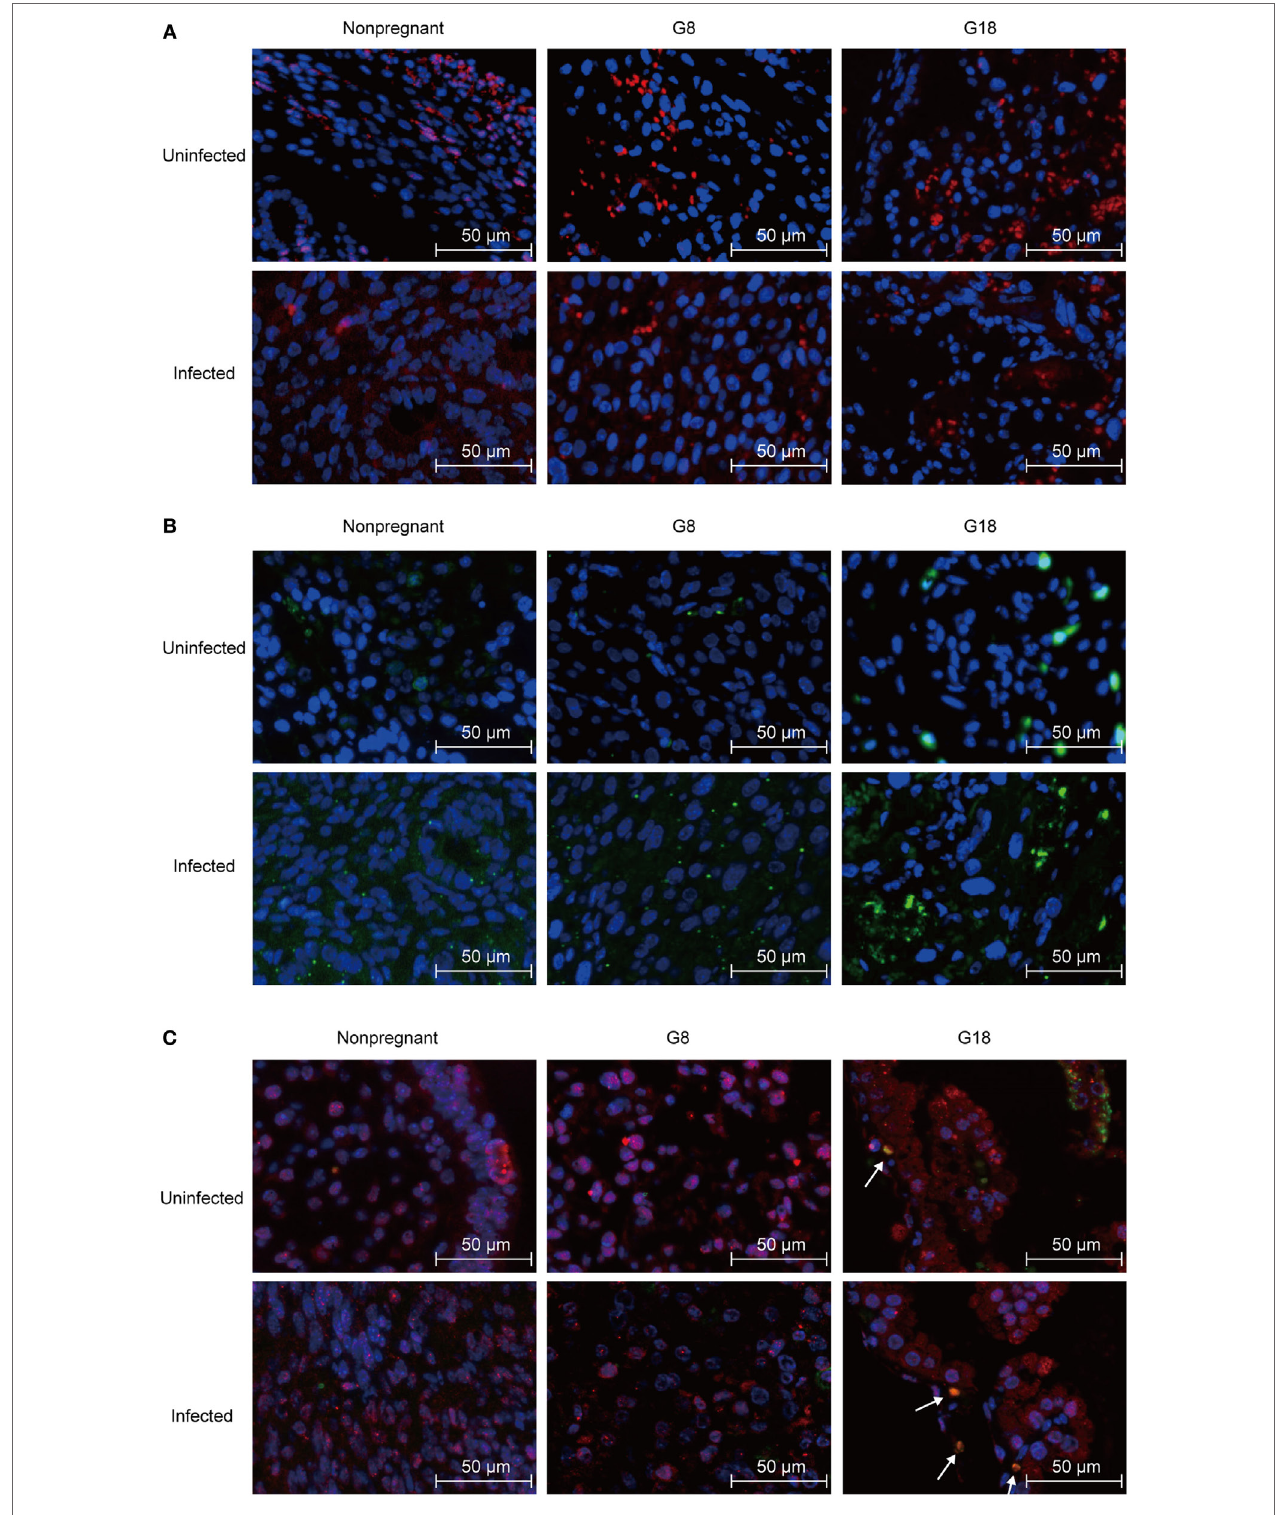
FigUre 2 | Expression of Foxp3 and programmed death-1 (PD-1) at the maternal–fetal interface of mice assessed by immunofluorescence staining. Nonpregnant and pregnant mice at G5 and G15 were injected with Toxoplasma gondii tachyzoites or PBS, respectively. All the animals were sacrificed at 3 days post infection (nonpregnant, G8 and G18). (a) Single staining of Foxp3 + cells. Blue, DAP1; red, Foxp3. Scale bars, 50 µm. (B) Single staining of PD-1 + cells. Blue, DAP1; green, PD-1. Scale bars, 50 µm. (c) Double staining of PD-1 and Foxp3. Blue, DAP1; green, PD-1; red, Foxp3. Scale bars, 50 µm. White arrows indicate PD-1 + Foxp3 + cells.